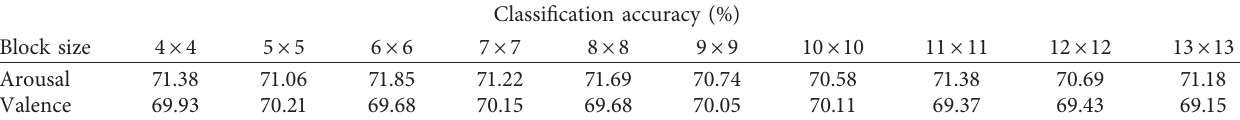
Table 2: Emotion recognition accuracy from different block sizes in the two